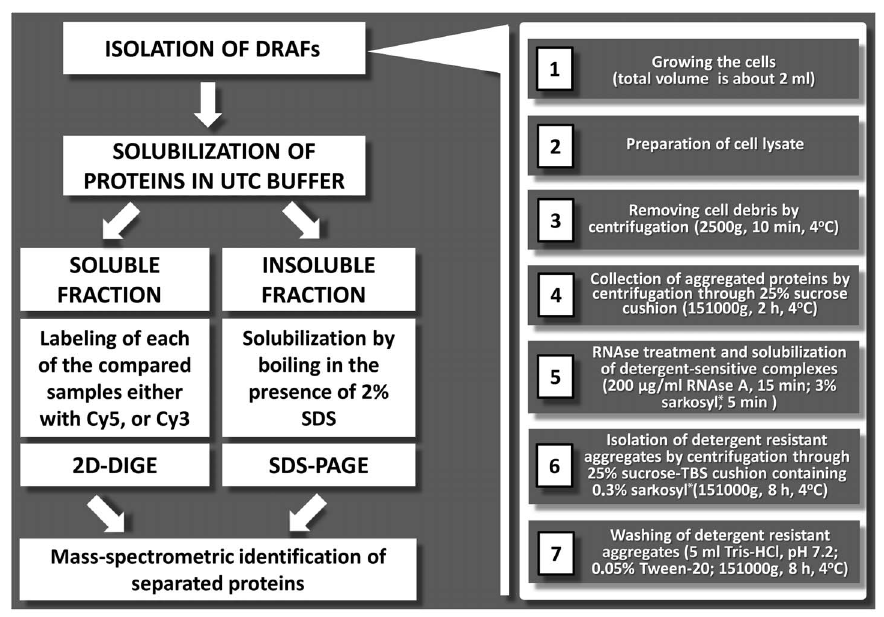
Fig. 1. Schematic representation of PSIA. Left panel illustrates the main stages of PSIA. Right panel describes the procedures for DRAF isolation. For details, see Materials and methods. *1% and 0.1% SDS can be used instead of 3% and 0.3% sarkosyl in steps 5 and 6, respectively.